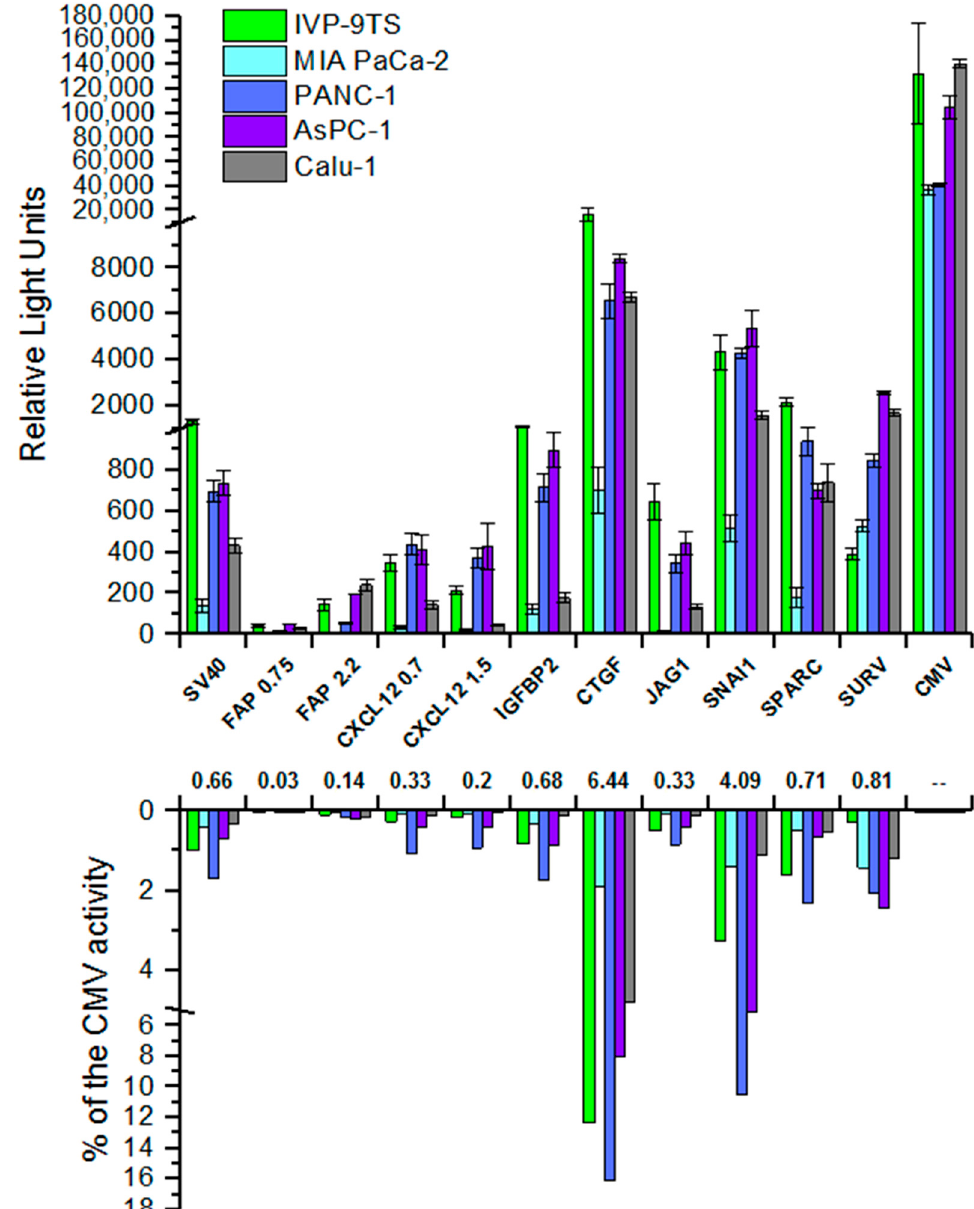
Figure 4. Relative promoter activities of the studied promoters in different human cell lines. The upper graph represents relative promoter activities (Y-axis) as ratios of the luciferase activity expressed by plasmids containing promoters under study to the R. reniformis luciferase activity. Luciferase activity expressed by promoterless pGL3-basic plasmid was subtracted. Mean values ( ± s.e.m.) of relative luciferase activity were calculated from three independent experiments. The Y-axis serifs designate scale breaks. The names of promoters are indicated below the top X-axis and correspond to both graphs. The numbers under the names of promoters indicate the median activity of promoters in cell lines relative to the activity of the CMV promoter. The lower graph represent the activity of the promoters under the study (Y-axis, expressed in %) relative to the activity of the CMV promoter in each cell line. Graph for the CMV activity (100%) is